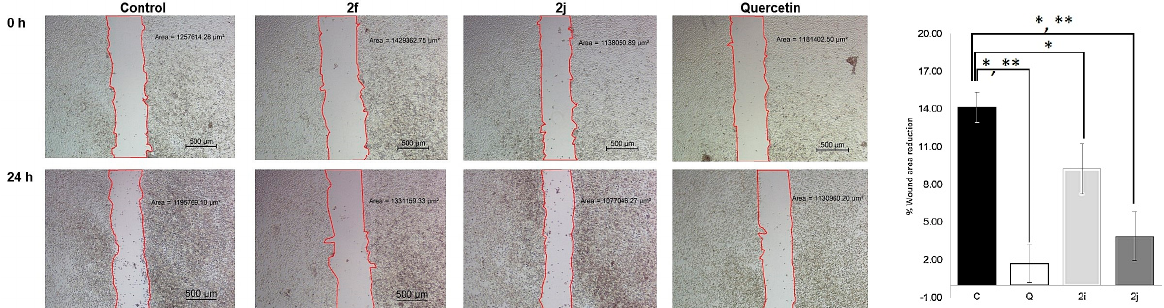
Figure 8. A scratch assay was performed to examine the migration ability of synthesized compounds 2f and 2j at 100 µM compared with untreated control. Representative pictures of the assay induce the migration of HeLa cells using quercetin as a reference. Pictures were taken at the start of the experiment (0 h) and 24 h later. Pictures of representative experiments are shown, and the means ± SD are illustrated in the graphs ( n = 3; *: p < 0.05 and **: p < 0.001, Turkey HSD). Scale bars represent 500 µ